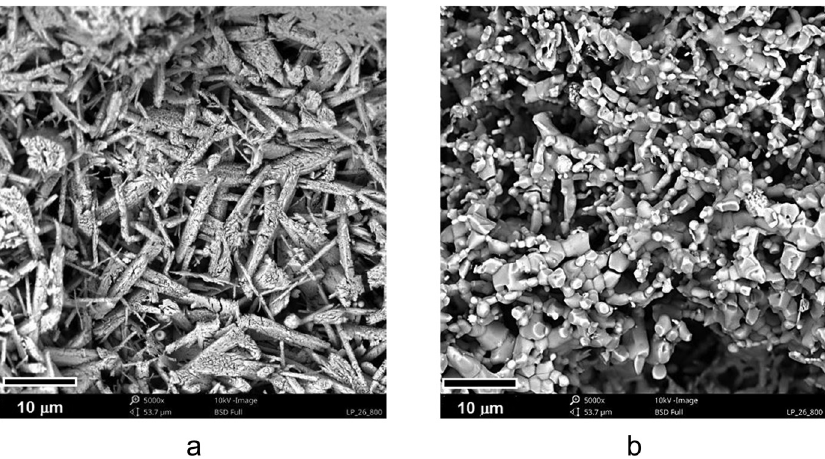
Figure 9: Crystal change at 800°C in composite with silica sand: ( a ) region with cracked crystals without shape change and ( b ) region with changed crystals.